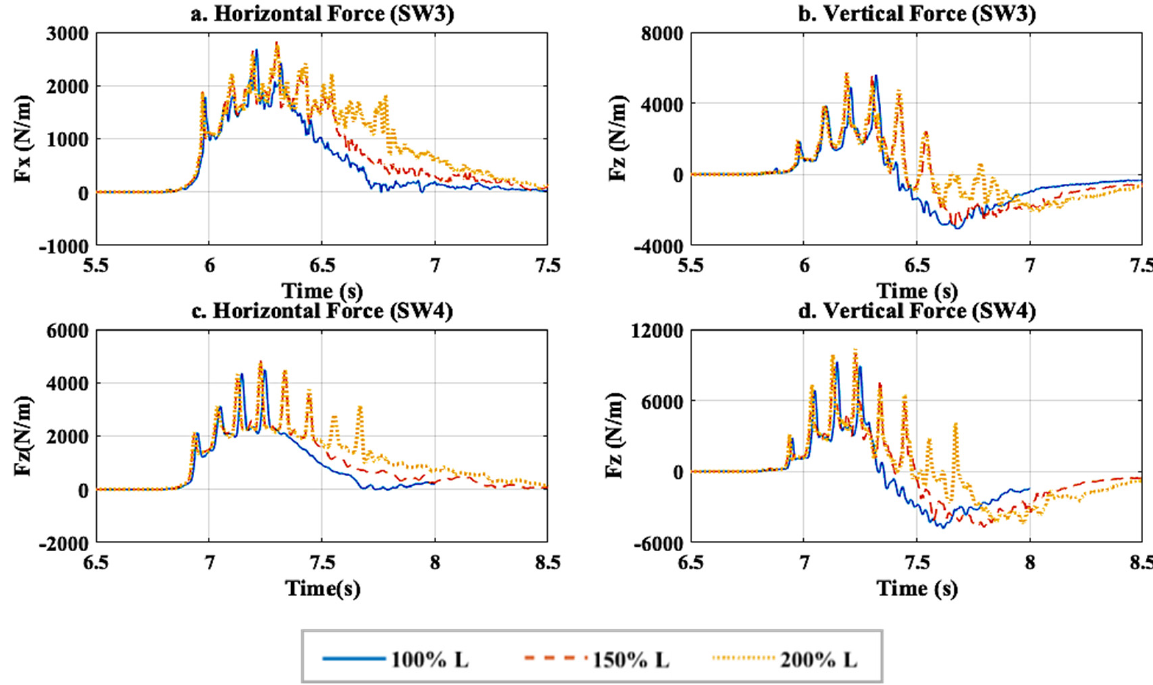
Figure 17. Wave force histories applied on three bridge decks with different widths.